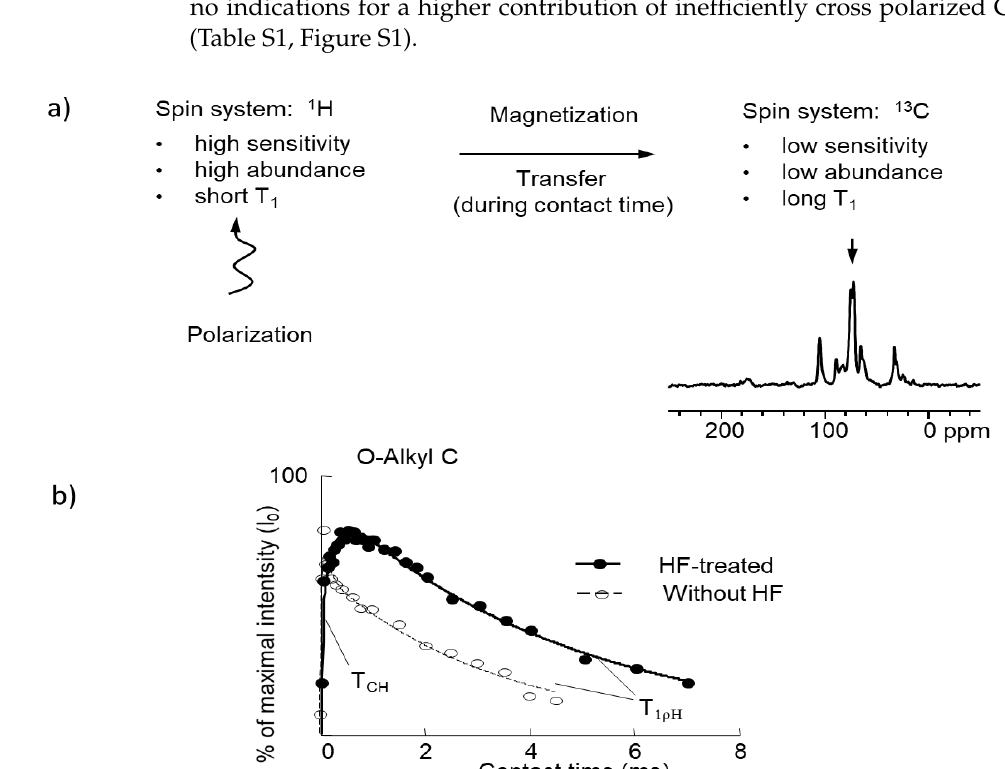
Figure 1. Scheme of the cross polarization process ( a ) and the 13 C intensity of O -alkyl C as a function of contact time measured for a soil sample (Cambisol, Ah horizon from the Sierra de Aznalc ó llar, Southern Spain) with and without demineralization with hydrofluoric acid (HF) (10% v / v ) ( b ) modified from [34].